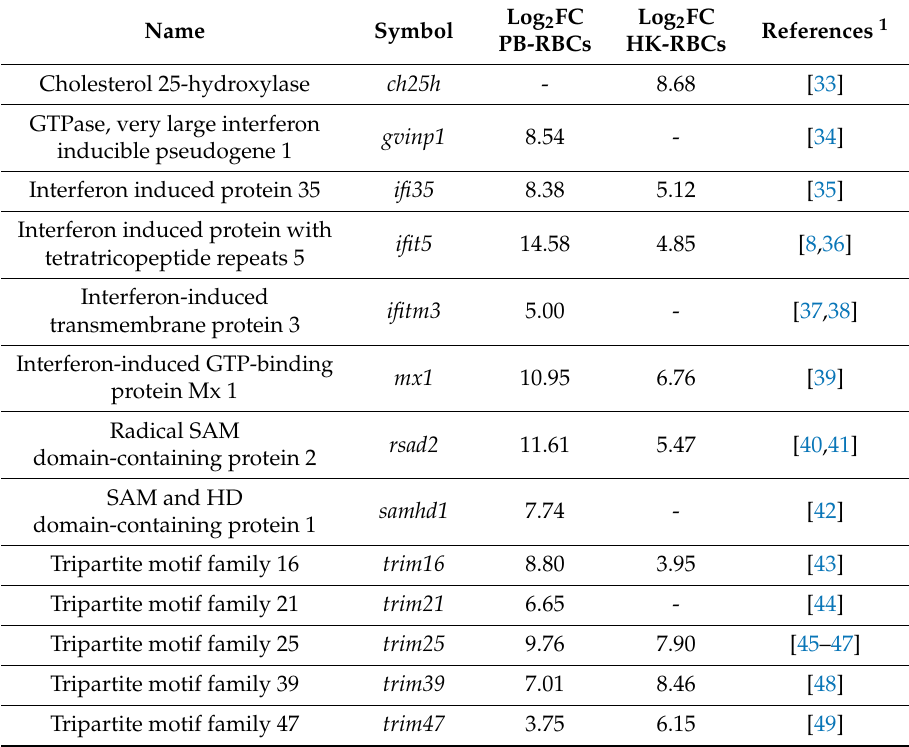
Table 2. Summary of interferon-stimulated genes (ISGs) / antiviral e ff ectors orthologues identified in transcriptomic